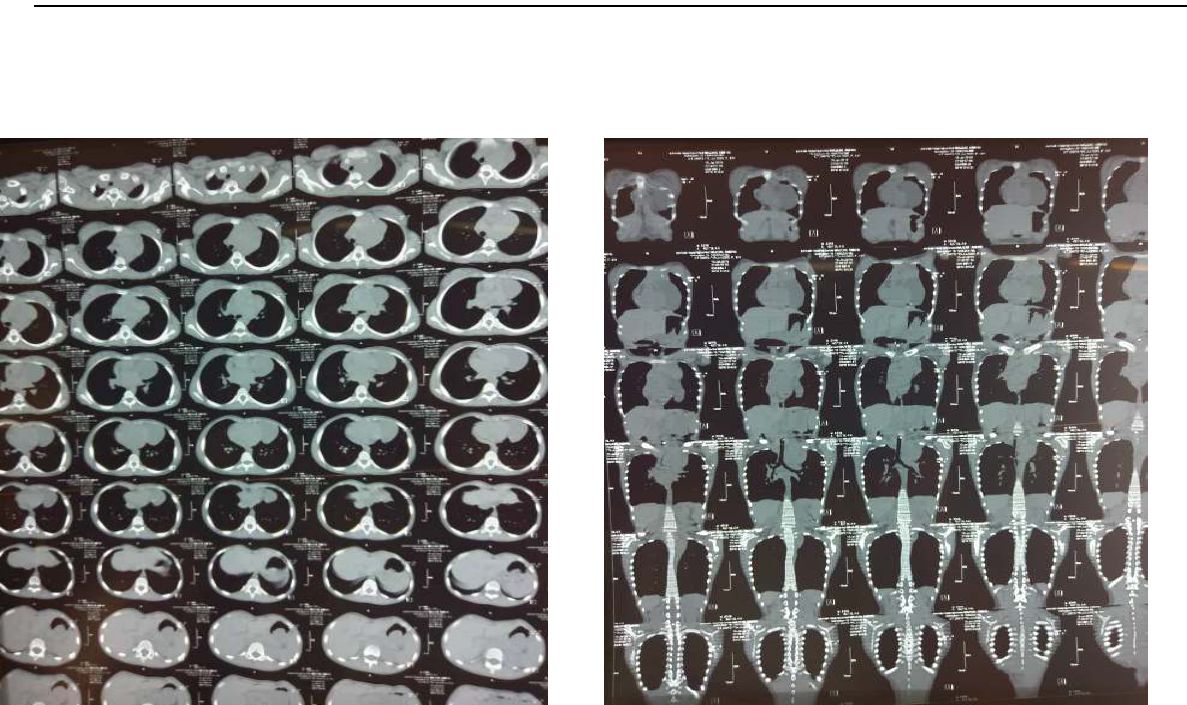
Figure 1: The CT scan Showing Anterosuperior and Middle Mediastinal